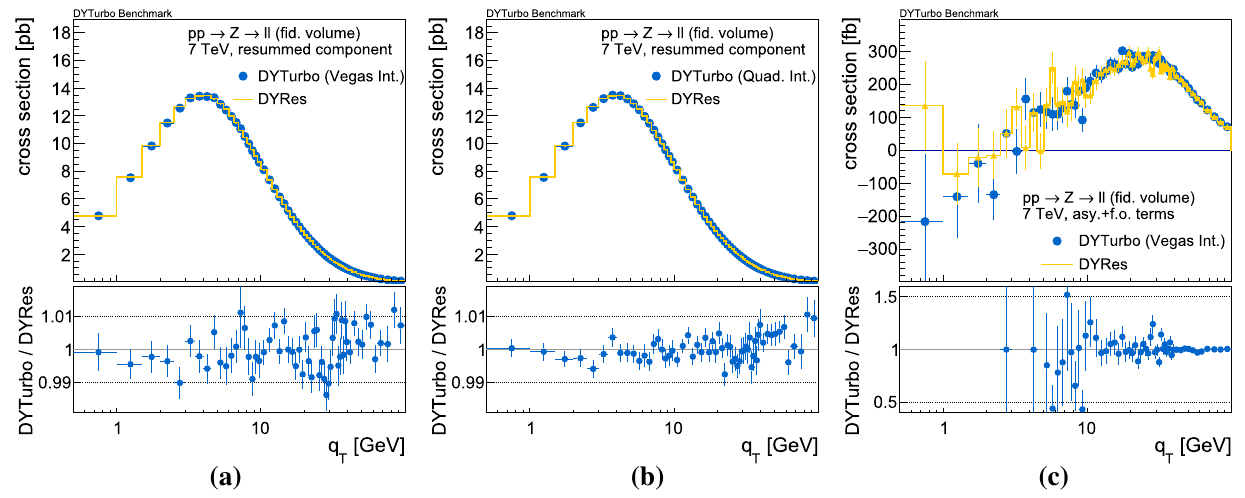
Fig. 6 Comparison of differential fiducial cross sections computed between DYRes and DYTurbo with Vegas integration. b Comparison √ s = 7 TeV as a function of the with DYRes and DYTurbo at of resummed component between DYRes and DYTurbo with Quadra- Z -boson transverse momentum. The Z -boson fiducial phase space is > 20 GeV, the lepton defined by the lepton transverse momentum p (cid:5) T pseudorapidity | η (cid:5) | < 2 . 4, and the invariant mass of the lepton pair 66 GeV < m < 116 GeV. a Comparison of resummed component